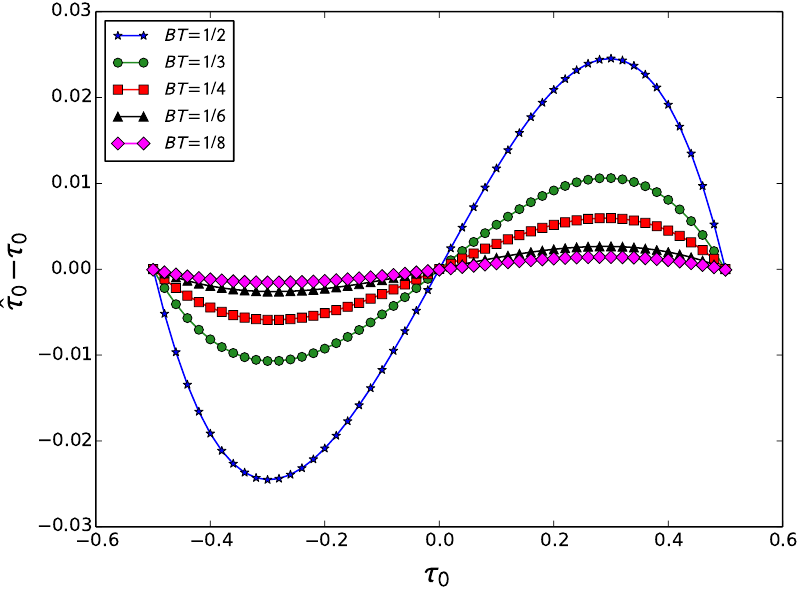
Figure 2. Fractional time-delay estimation error against bandwidth ( θ =